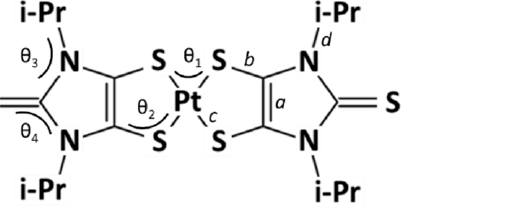
Figure 3. Chemical structure of [Pt(iPr 2 timdt) 2 ] and illustration of notion of the bonds and angles are interested. Table 1. Table of average bond lengths (in Å), bond angles (in degree), and their deviation from average (placed in parentheses) in the optimized structures of [Pt(iPr 2 timdt) 2 ] complexes. The Figure 3 illustrates the positions of the bonds and angles being investigated.